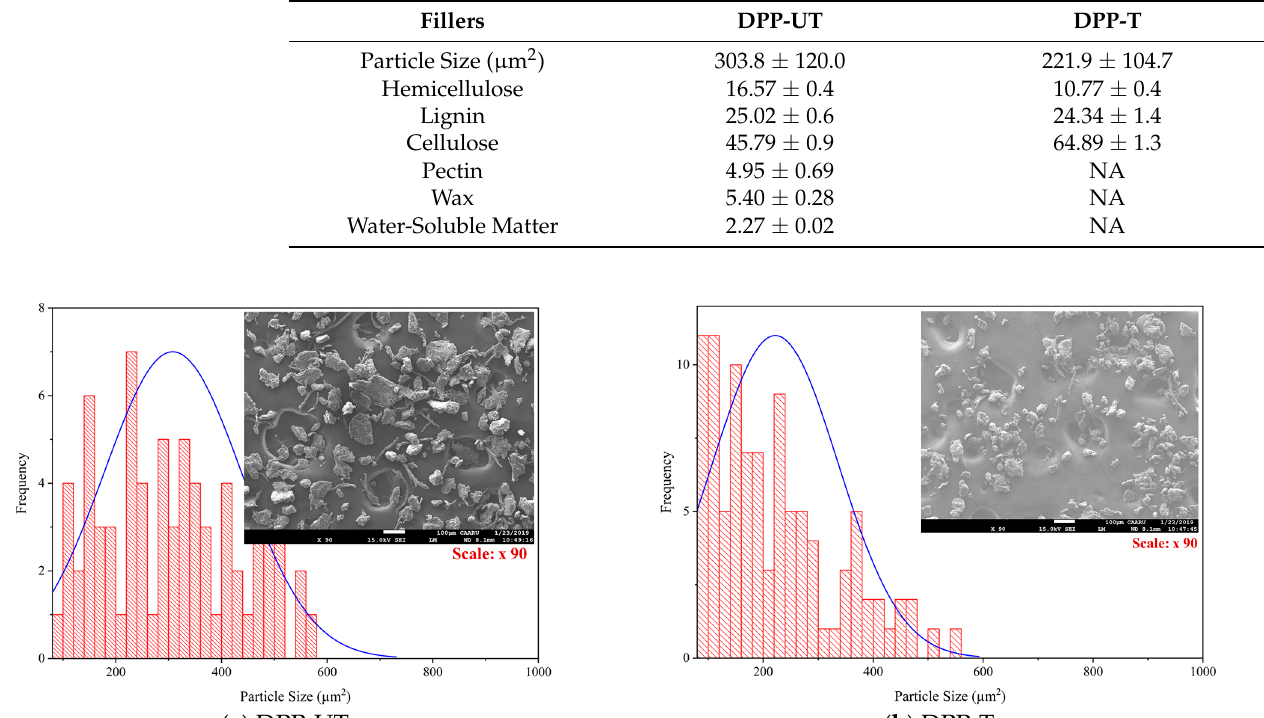
Table 1. Chemical compositions (%) of untreated and treated date palm powders (NA: not applicable). Fillers DPP-UT DPP-T Particle Size ( µ m 2 )